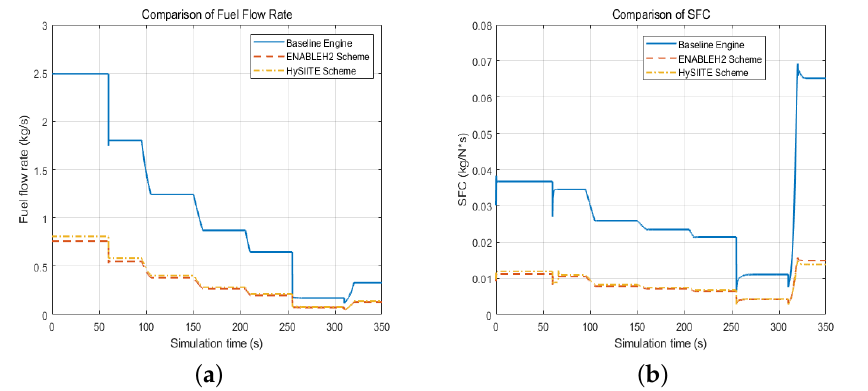
Figure 8. SFC comparison of baseline engine, ENABLEH2 scheme, and HySIITE scheme. ( a ) Com- parison of fuel flow rate; ( b ) comparison of